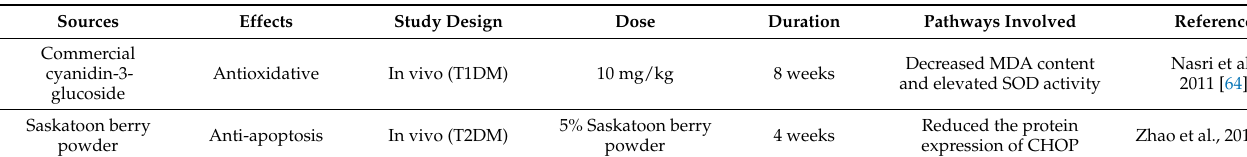
Table 1. Summary of effects of anthocyanin and the targeted pathways involved in diabetic cardio- vascular